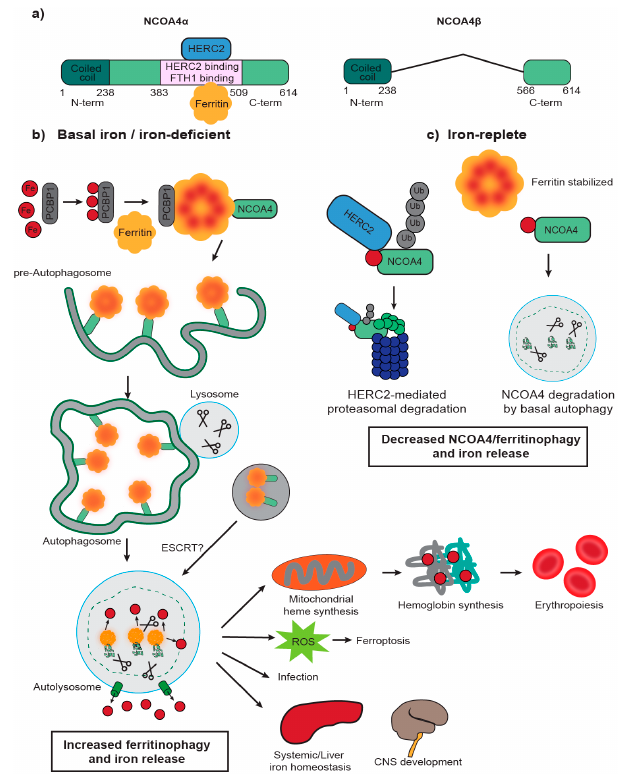
Figure 1. NCOA4-mediated ferritinophagy pathway is regulated by intracellular iron. ( a ) Schematic of NCOA4 transcript variants in humans: NCOA4 α and NCOA4 β . NCOA4 α is a 614 Aa protein (70 kDa) with an N-terminal coiled coil domain and a C-terminal domain that contains a FTH1 and HERC2 binding domain (Aa 383–509). NCOA4 β (286 Aa, 35 kDa) shares with NCOA4 α the N-terminal domain and a portion of the C-terminal domain. ( b ) Poly rC—binding protein 1 (PCBP1) binds to iron